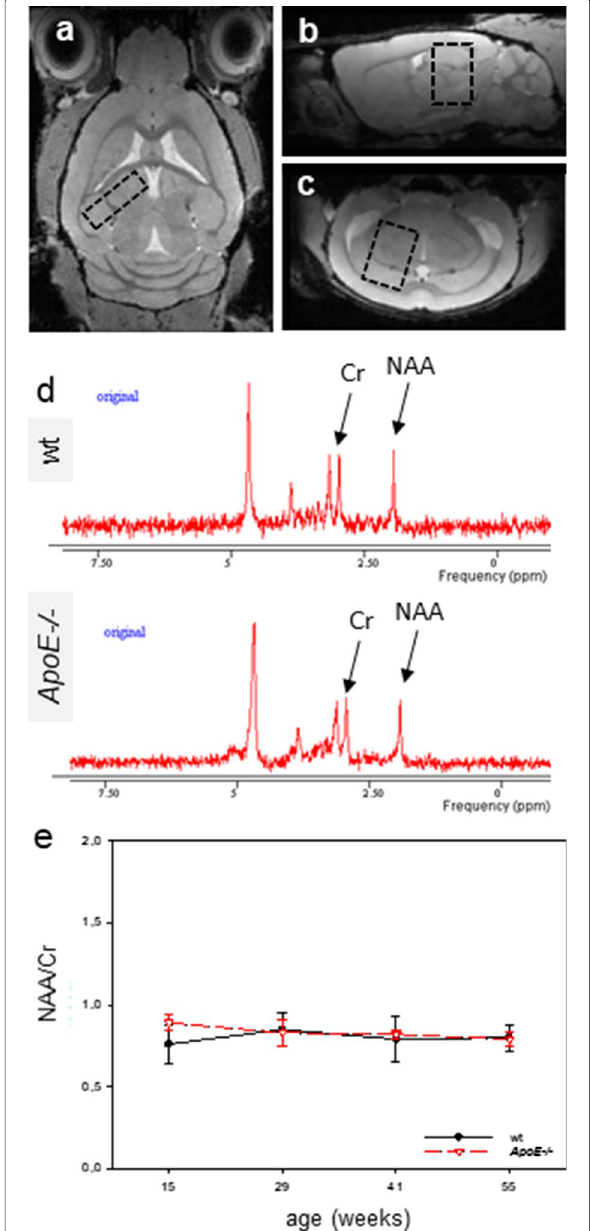
Fig. 2 Transversal ( a ), sagittal ( b ) and coronal ( c ) T1 weighted MRI images including the position of the spectroscopy voxel (black dashed box) of a wild type (wt) mouse. An example of a MRS spectrum of a wt (upper) and an Apolipoprotein E-deficient ( ApoE / ) mouse (lower) as derived from the voxel of interest is − − shown in ( d ). Two prominent metabolites, e.g. N -Acetylaspartate (NAA resonates at 2.0 ppm) and creatine (Cr at 3.0 ppm) are evident and were further evaluated. e Diagram of the NAA/Cr ratio in wt and ApoE / mice. Values are given as mean − −